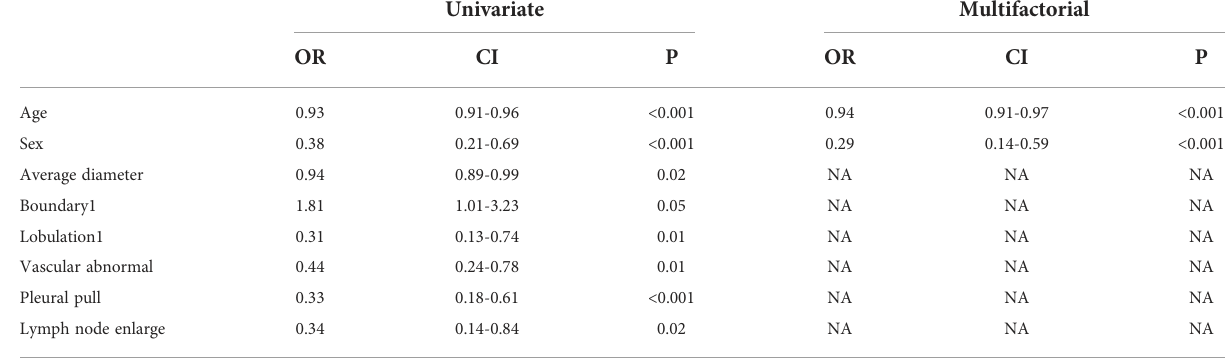
TABLE 2 Univariate and multifactorial analysis of clinical radiological characteristics.